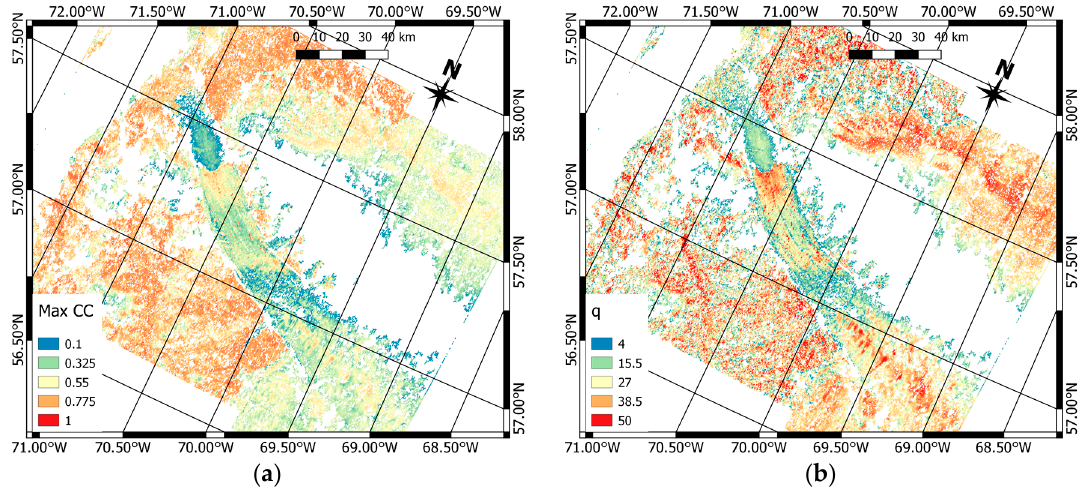
Figure 4. PG, quality parameters maps obtained by processing the IW SLC pair 6–12 January 2017. ( a ) Maximum correlation. ( b ) Ratio between the peak and the background of the correlation matrix (q-parameter).